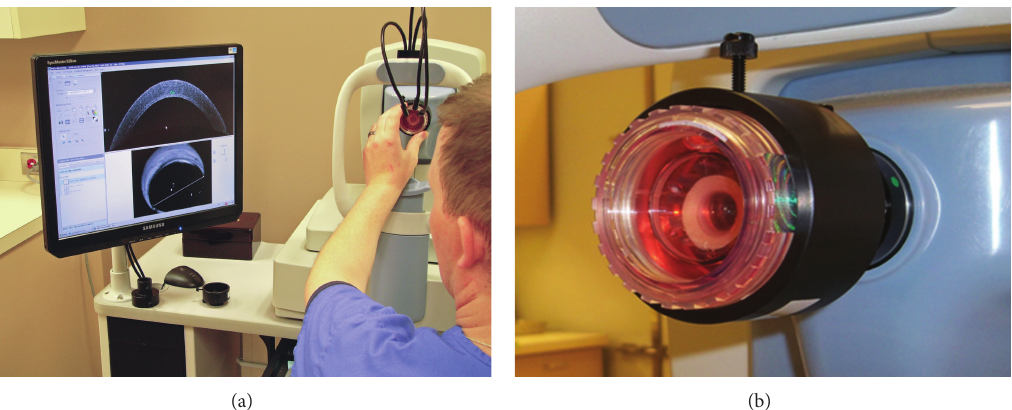
Figure 1: (a) Setup for FD-OCT imaging. The viewing chamber containing the corneoscleral disc is placed in the holding device while the cornea is scanned. In order to minimize the risk of contamination, the cornea remains in medium throughout the scan. (b) View chamber